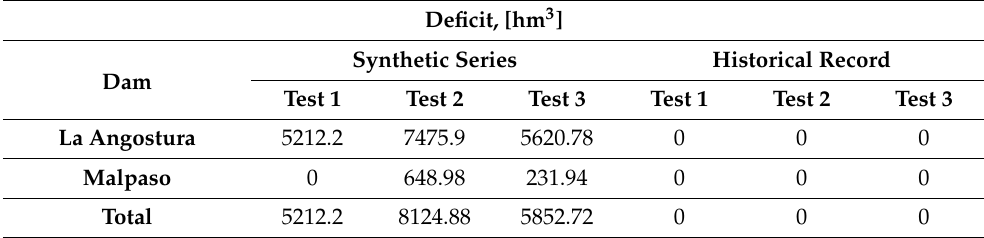
Table 10. Comparison of total deficit: 10 synthetic series vs. historical